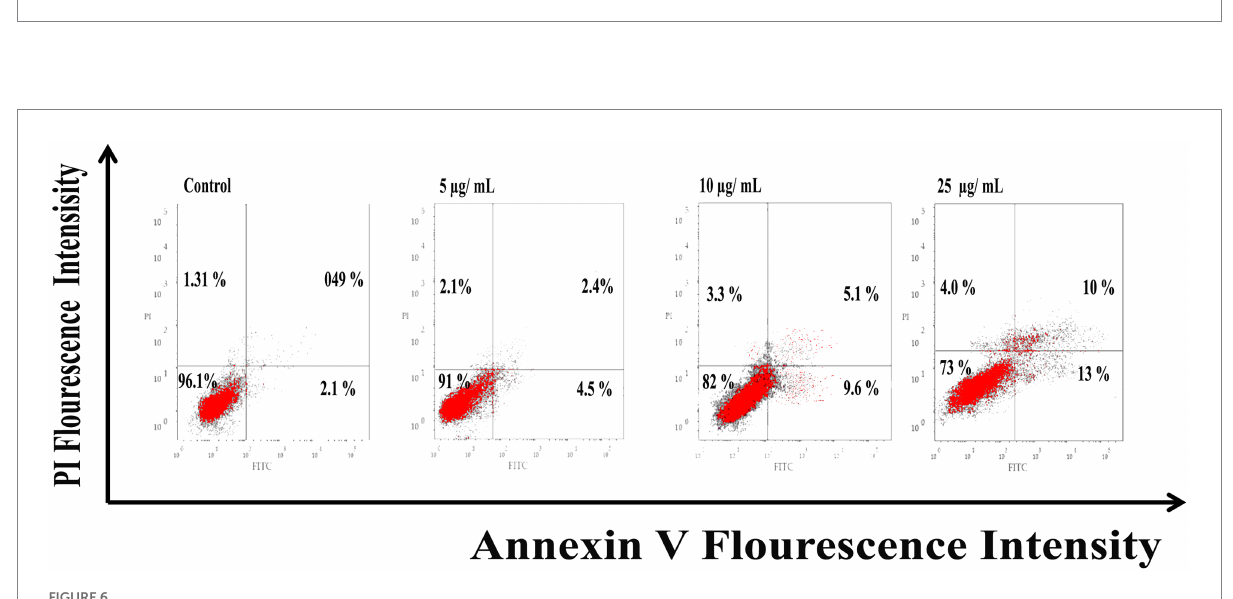
FIGURE 6 Flow cytometric analysis of silver magnetite core shell nanoparticles induced apoptosis against Escherichia coli